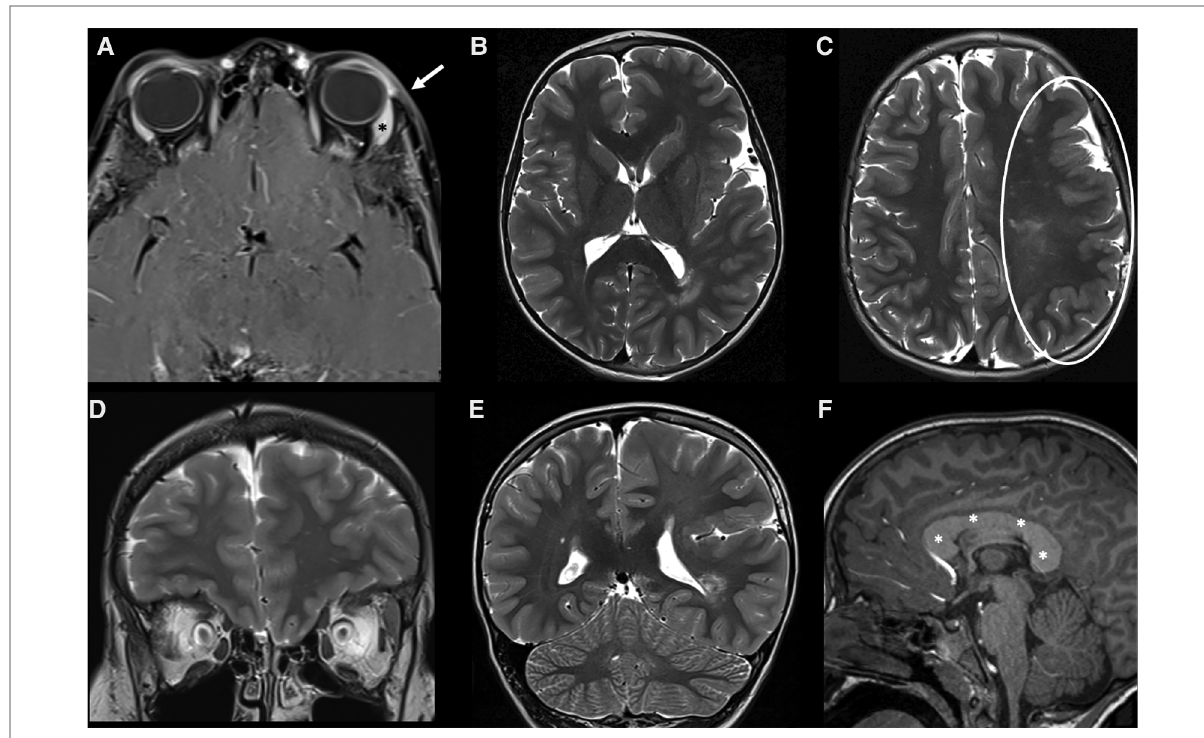
FIGURE 8 MRI of a 7-year-old Male child with left-sided facial hypertrophy with multiple reddish macules on the face and left orbit, with a clinical suspicion of macrocephaly-capillary malformation (M-CM). ( A ) A slight thickening associated with subtle enhancement of the skin and subcutaneous tissue (white arrow) of the left orbit is noted on fat-sat post-contrast T1 images, corresponding to one of the clinically visible macules. A slight hypertrophy of the left lacrimal gland is also noted (asterisk). ( B – E ) Axial ( B,C ) and coronal ( D,E ) images of the brain revealed a marked asymmetry of the cerebral hemispheres, with left being larger than right consistent with left hemimegalencephaly. The cortex of the enlarged hemisphere is also diffusely polymicrogyric (white circle in C ). ( F ) on the post contrast sagittal T1 an abnormal thickness of the entire corpus callosum is also evident (white asterisks). A mosaic mutation of PIK3CA gene was discovered, con fi rming the clinical suspicion of